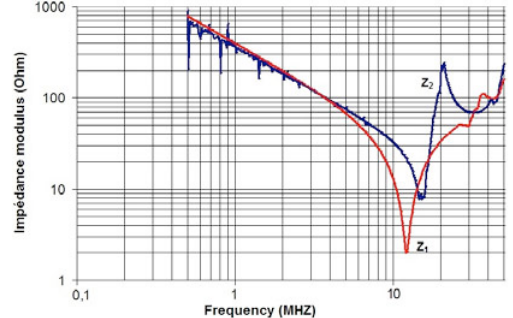
Figure 8: Z input impedance of the converter: Z CM